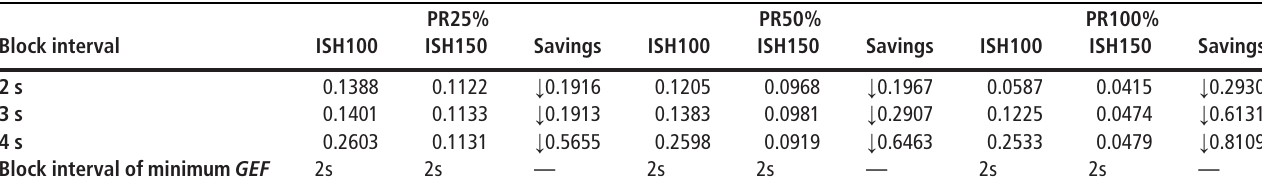
Table 6 GEF values with block interval of 2s, 3s and 4s corresponding to different PRs and ISHs Block